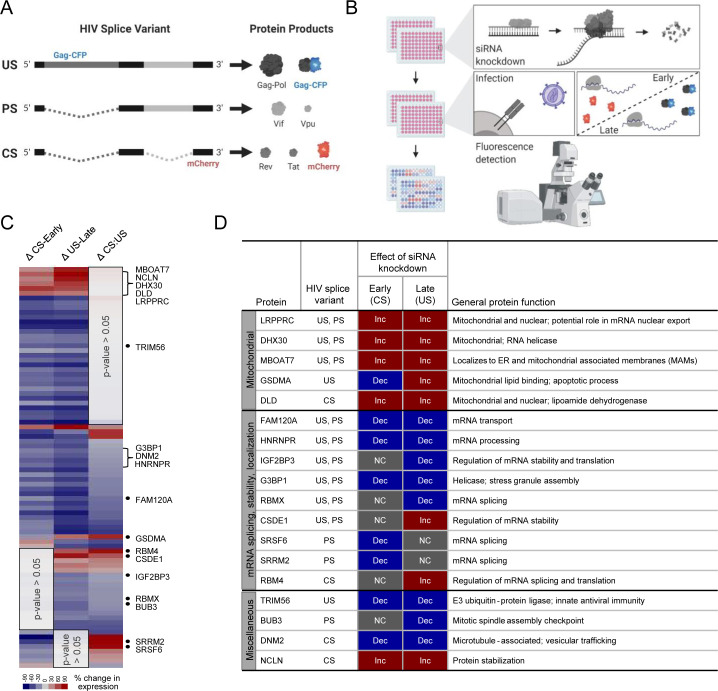
Screen for host protein effects on early and late HIV gene expression.(A) The HIV-1 reporter virus expresses mCherry from the nef locus as a completely spliced (CS) RNA ‘early’ stage reporter and Gag fused to cyan fluorescent protein (CFP) as a unspliced (US) RNA ‘late’ stage reporter. (B) In 96-well plates, 293 T-cells engineered to stably express an F-actin-YFP fusion protein as a host gene control (293T-ACT-YFP cells) were transfected with gene-specific siRNAs, incubated for 48 hr to initiate knockdown (KD), and then transfected with siRNAs for a second time prior to infection with the HIV reporter virus at a multiplicity of infection (MOI) of ~1. Cells were fixed at 48 hr post-incubation. Fluorescence microscopy was used to quantify CFP and mCherry levels. (C) Heatmap of HIV gene expression changes after siRNA KD of host proteins, with 84 of 121 proteins showing statistically significant changes in early and/or late HIV gene expression (p-values<0.05). (D) Table summarizes Hybridization Purification of RNA-Protein Complexes Followed by Mass Spectrometry (HyPR-MS) and siRNA KD results for 18 genes of interest wherein KD was confirmed to be significant based on either quantitative immunoblot or immunofluorescence. Figures A and B created with BioRender.com.Figure 3—source data 1.siRNA KD and fluorescence expression data analysis.